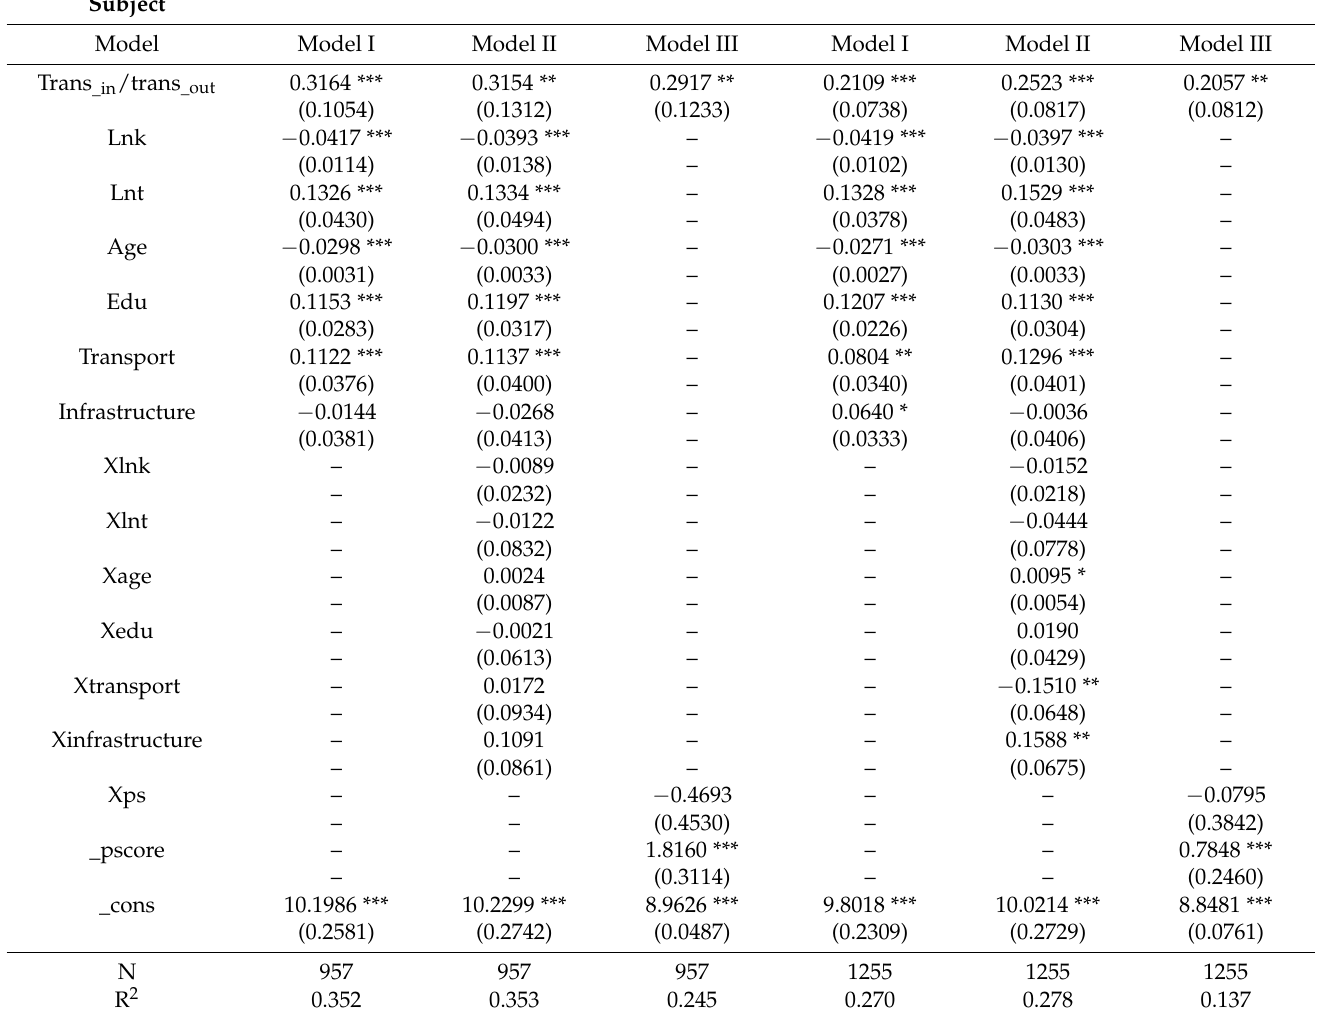
Table 6. Estimation Results for the ATE of Aggregate Labor Productivity of transfer-in and transfer- out